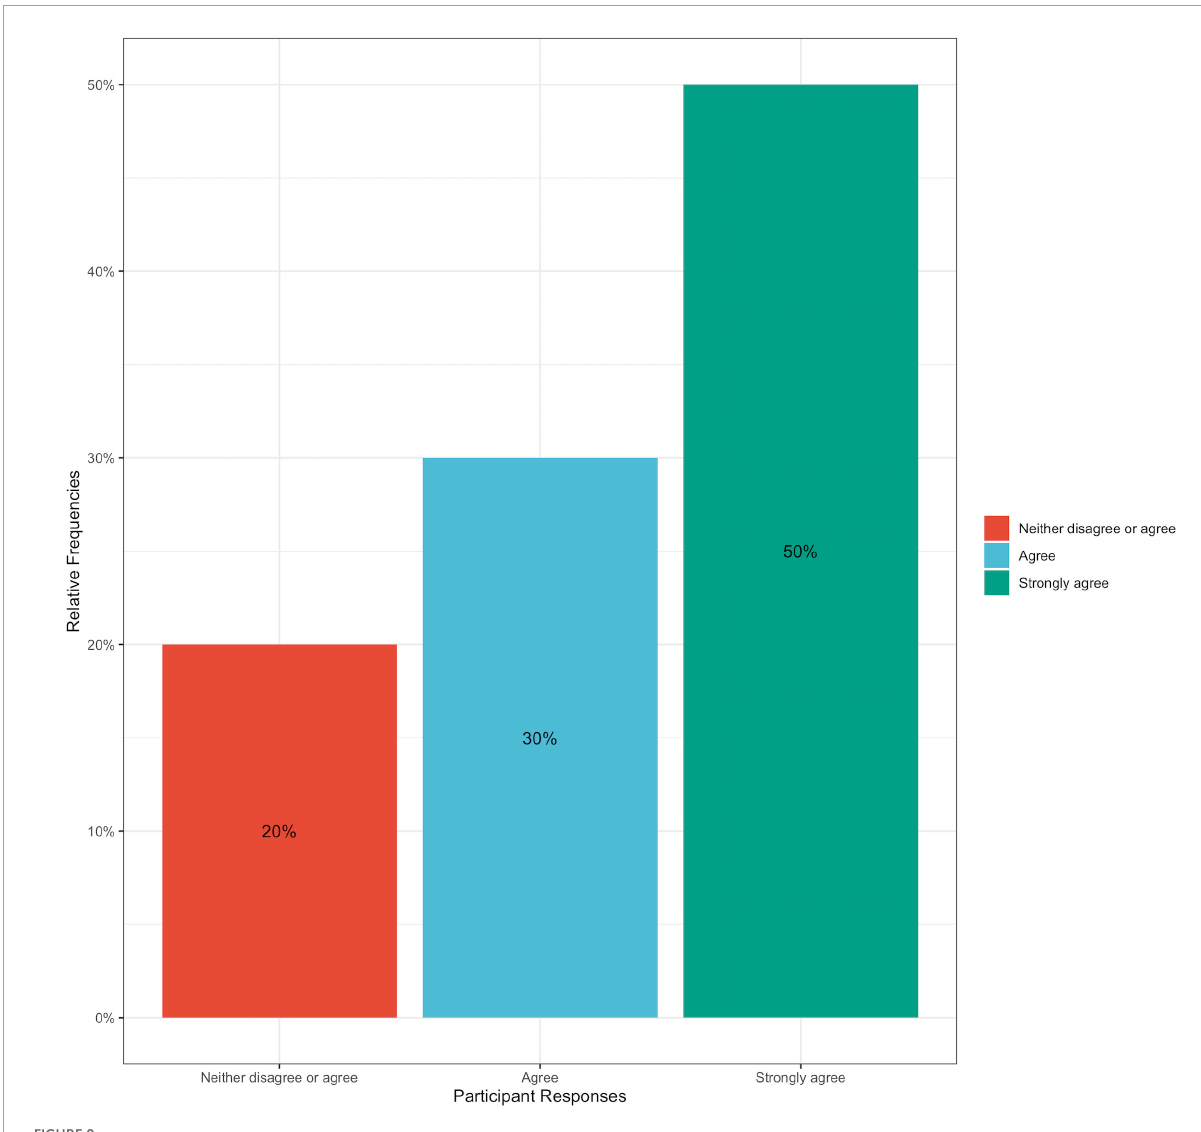
FIGURE8 Bar graph of percentage of participant responses to post-intervention survey question: How much do you agree that the following statement is true for you: “I intend to continue to work to achieve dietary behavior change to improve my blood pressure”? Answer choices included: Strongly agree, agree, neither agree or disagree, disagree, and strongly disagree.